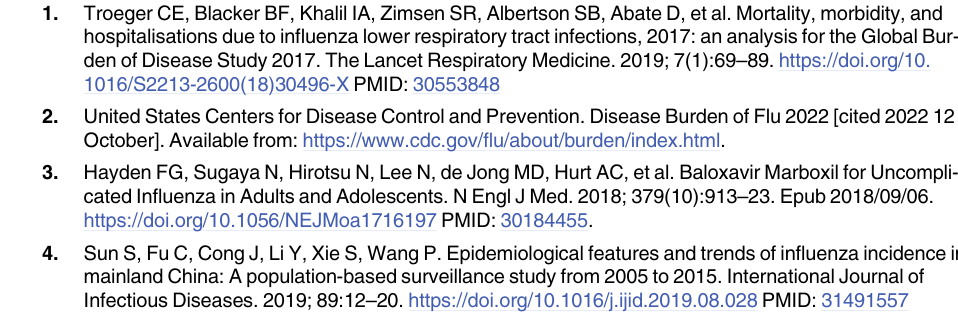
S2 Table. Secondary cases of influenza infection observed in the Phase 3 BLOCKSTONE study following treatment of index patients. S1 Fig. Example individual viral shedding curves using observed data and estimated data from the PK − VK model. S2 Fig. Goodness-of-fit plot between observed and estimated data for individuals using the PK − VK model. S3 Fig. Population-level infectiousness over time. S1 Text. Technical